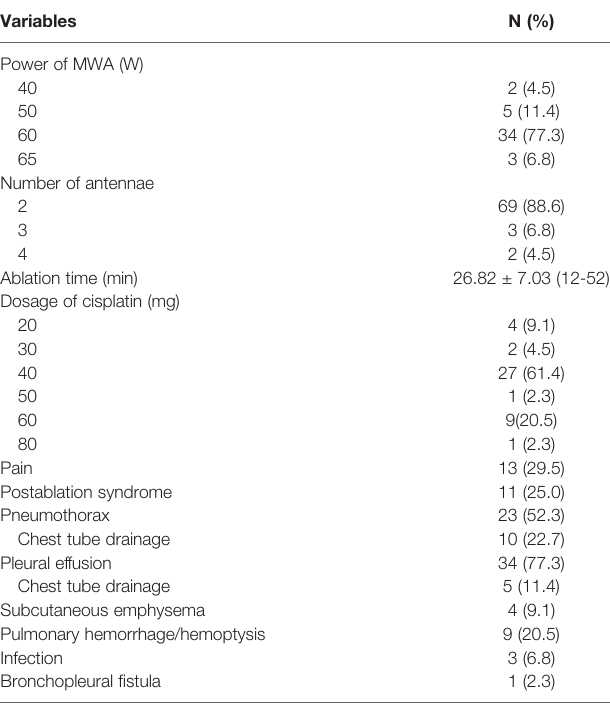
Continuousdata arepresented as mean± SD (range).Numbers in parentheses represent percentages or ranges. MWA, microwave ablation; ITC, intratumoral